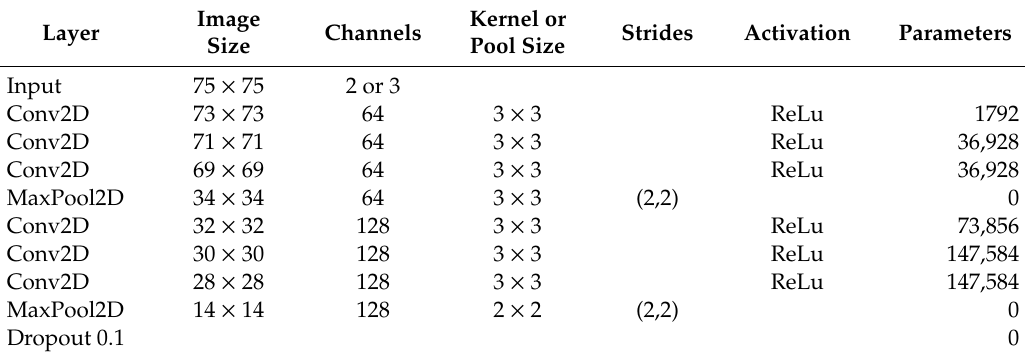
Table 2. As Table 1 but for layers and hyperparameters of CNN2.